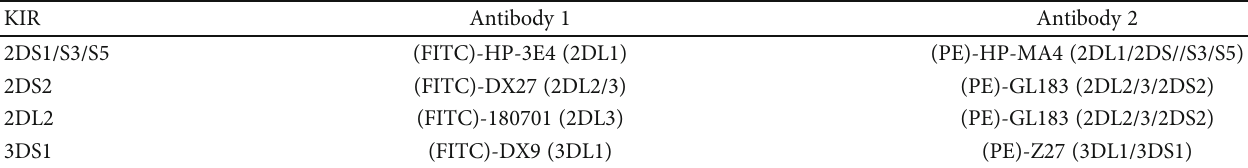
Table 3: Antibody combinations used to determine the expression of